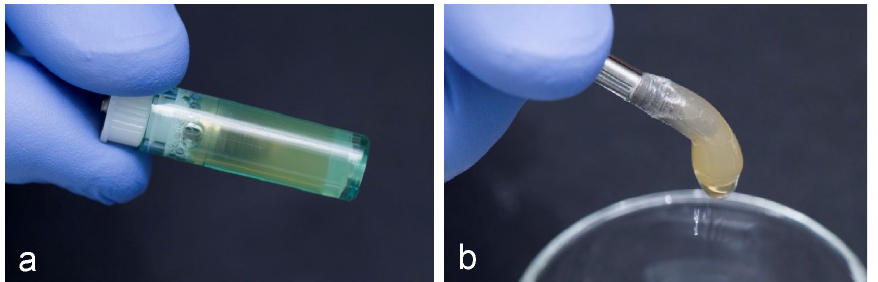
Figure 8. ( a ) CGF inserted into dedicated tube containing an Immediateload ® , Swiss dental implants, diameter 4 mm, height 8 mm; ( b ) CGF-permeated implant after centrifugation using Round up (Silfradent srl).